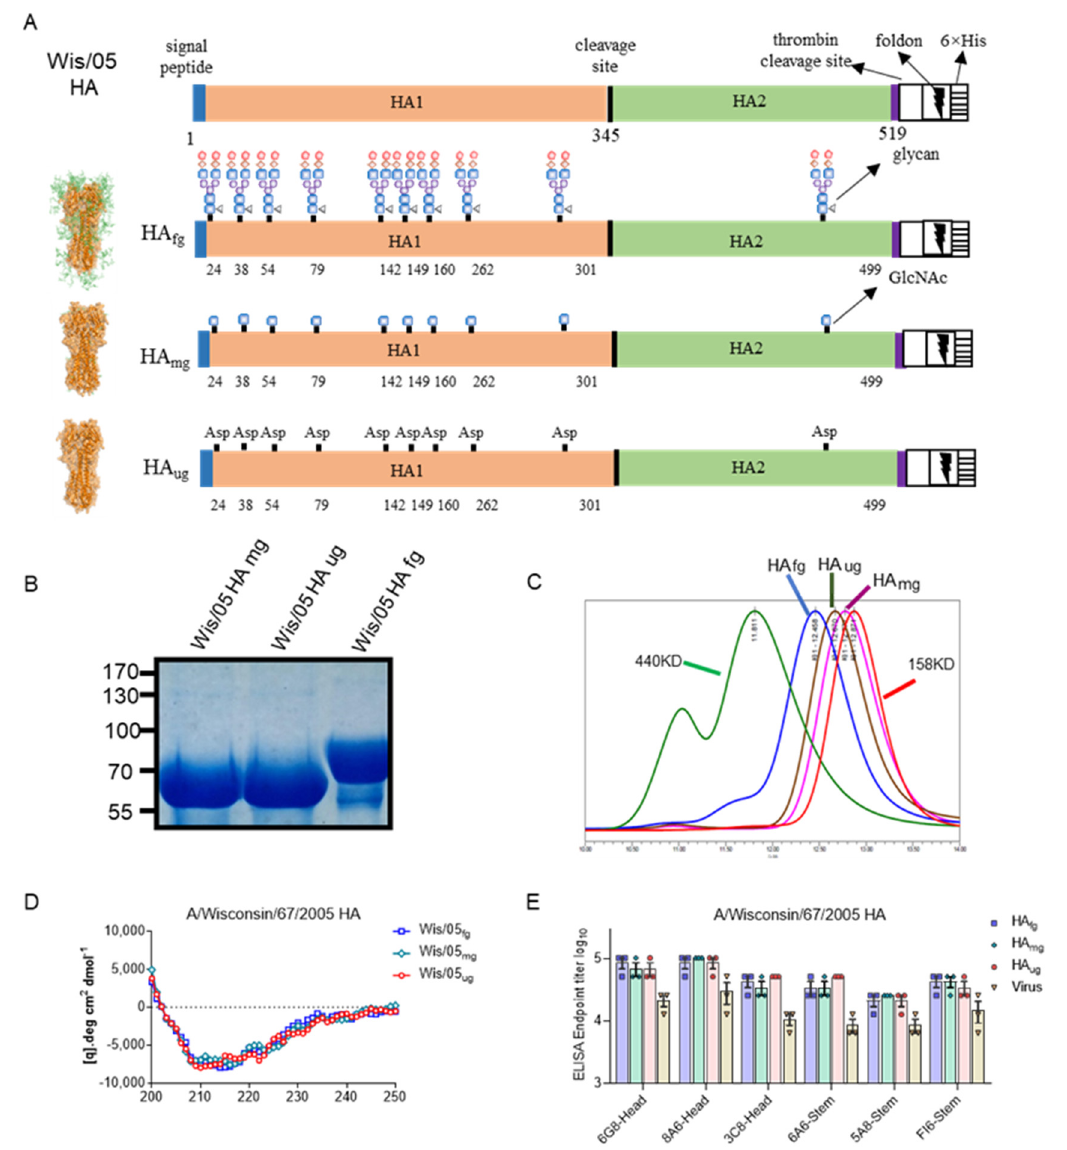
Figure 1. Deglycosylated modified HA proteins treated with different glycosidases could retain structural integrity and primary epitope conformations. ( A ) Schematic representation of the Wis/05 (H3N2) HA proteins with different lengths of glycans at the 11 glycosylation sites: HA fg with the typical complex type N − glycans; HA mg was obtained by treatment with Endo H, only a GlcNAc at its N-glycosylation sites; HA ug was obtained by treatment with glycosidase PNGase F without gly- cans at its N-glycosylation sites. Schematic of the wild-type and glycosidase-modified HAs